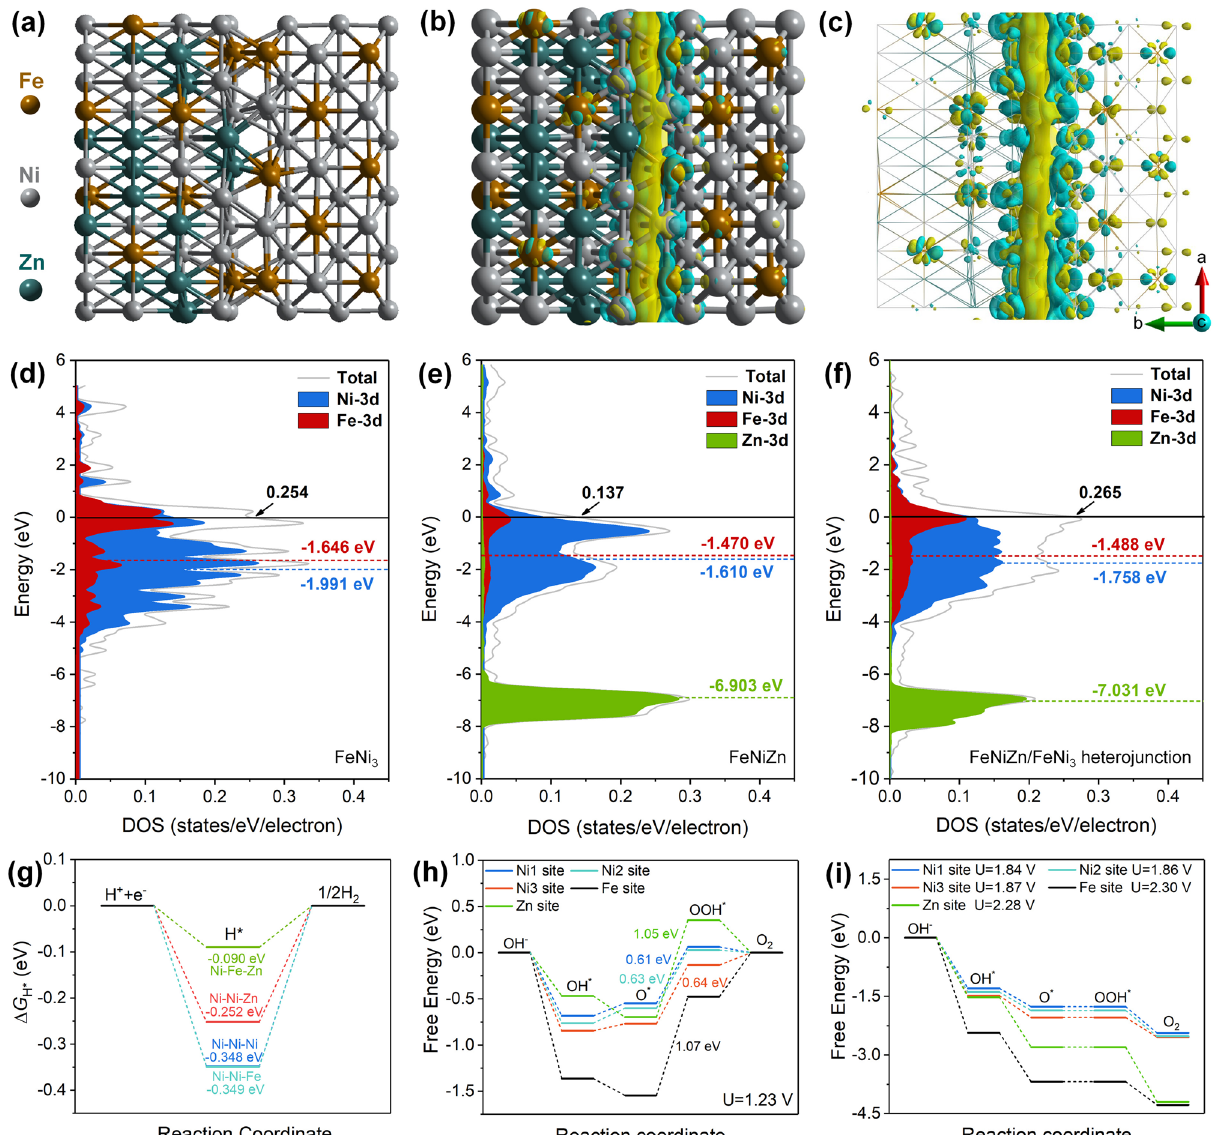
Fig. 7 a The optimized structure of FeNiZn/FeNi 3 heterojunction (orange balls are Fe, grey ones are Ni, and dark green ones are Zn). b, c Calculated charge density difference of FeNiZn/FeNi 3 heterojunction. The calculated DOS of d FeNi 3 , e FeNiZn, and f FeNiZn/FeNi 3 hetero- junction, the dashed lines represent the d band center energy level. g The calculated Δ G H* for the HER process at Ni–Ni–Ni, Ni–Ni–Zn, Ni–Ni– Fe, and Ni–Fe–Zn sites on FeNiZn/FeNi 3 @NiFe-24 h heterojunction. h Calculated free energy diagram for the OER at Fe, Ni, Zn sites at the applied potential of 1.23 V, and i the calculated free energy diagram for the OER on Fe, Ni, and Zn sites at different applied